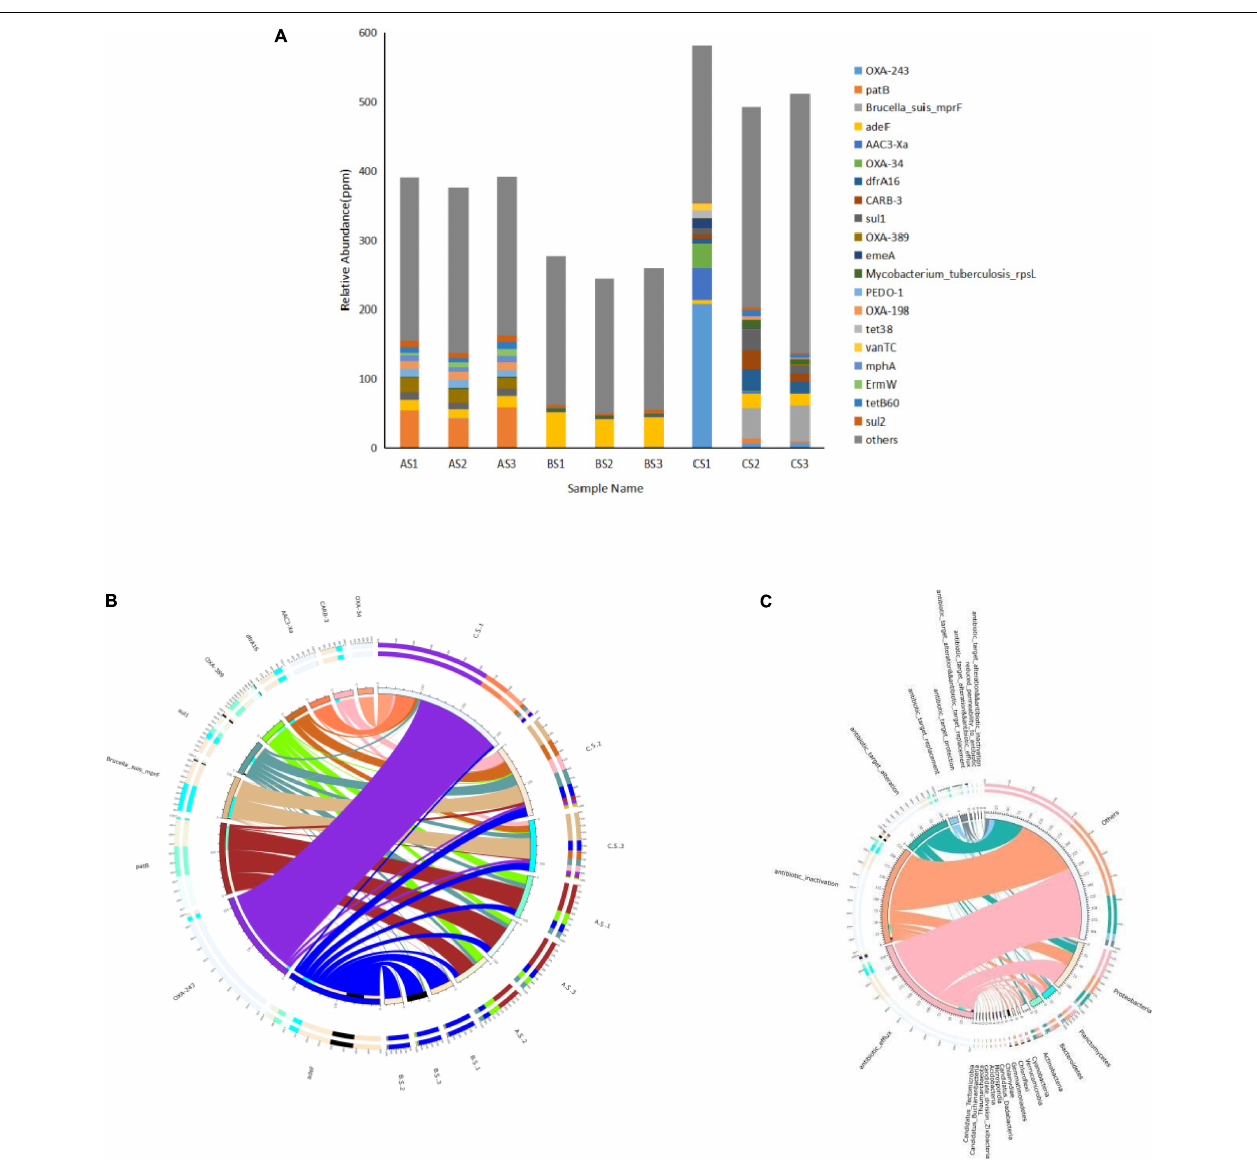
FIGURE 5 | (A–C) Figure 5A represents the relative abundance of all the genes in each sample (unit ppm, the result of magnifying the original relative abundance data by 106 times). Figure 5B represents the ARO with the maximum abundance of top 10 (the circle diagram is divided into two parts, the sample information on the right and ARO information on the left). Different colors in the inner circle represent different samples and AROs, with the scale being relative abundance and the unit being PPM. Figure 5C represents an overview of resistance mechanisms and species (the circle diagram is divided into two parts). The right side shows the information of species at the level of phylum and the left side shows the information on resistance mechanism. The inner circle shows the resistance mechanism of different species and resistance with different colors and the scale shows the number of genes. On the left is the sum of the number of resistance genes in the species with this resistance mechanism and on the right is the sum of the number of resistance genes in the species with different resistance mechanisms. AS, water sample; BS, biofloc sample; CS, intestinal